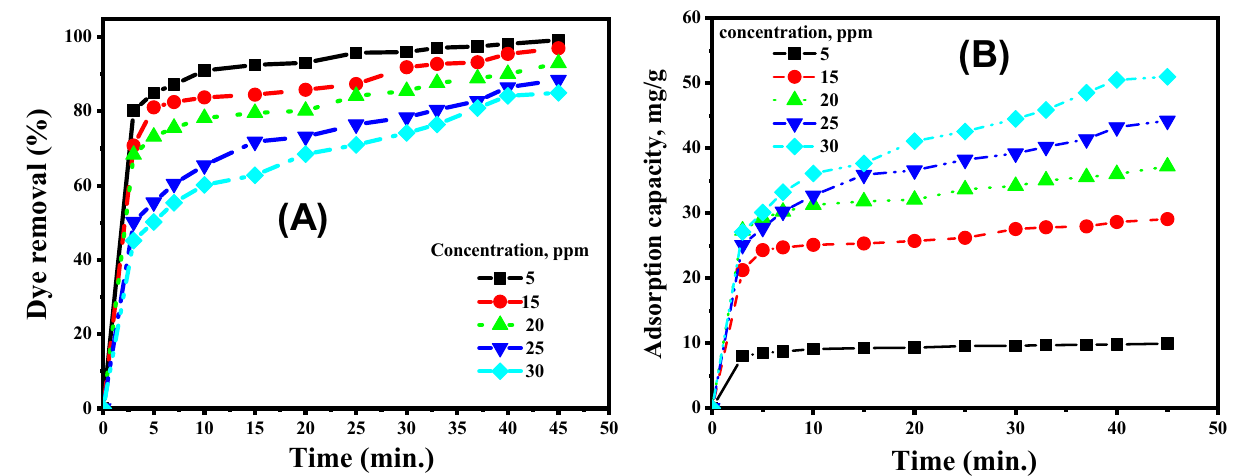
Figure 7. Effect of MB dye concentrations and contact time on ( A ) the removal % of dye and ( B ) The amount of dye adsorbed at 25 °C and pH 7 by 50 mg of AC500/NZ adsorbent.